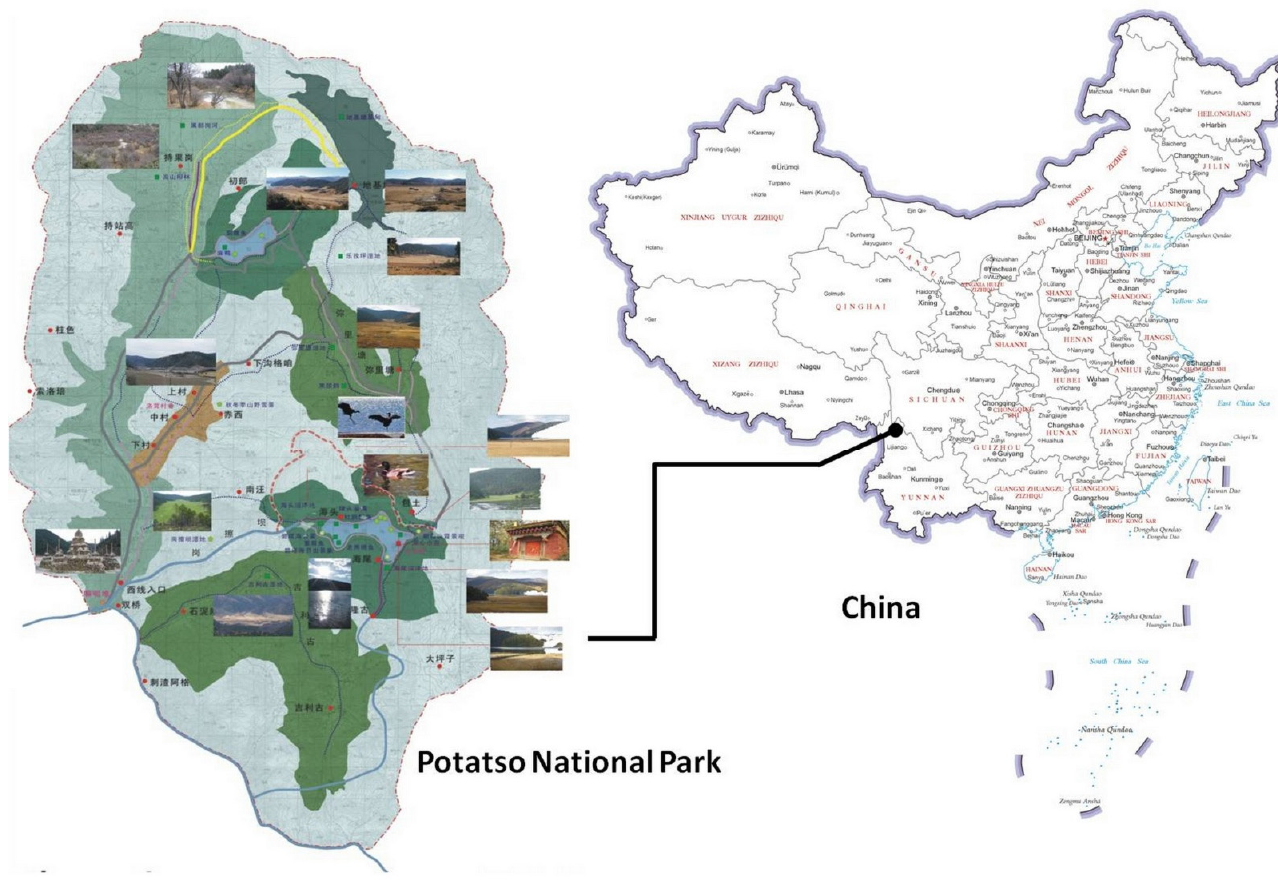
Figure 3. Geographical location of Potatso National Park.